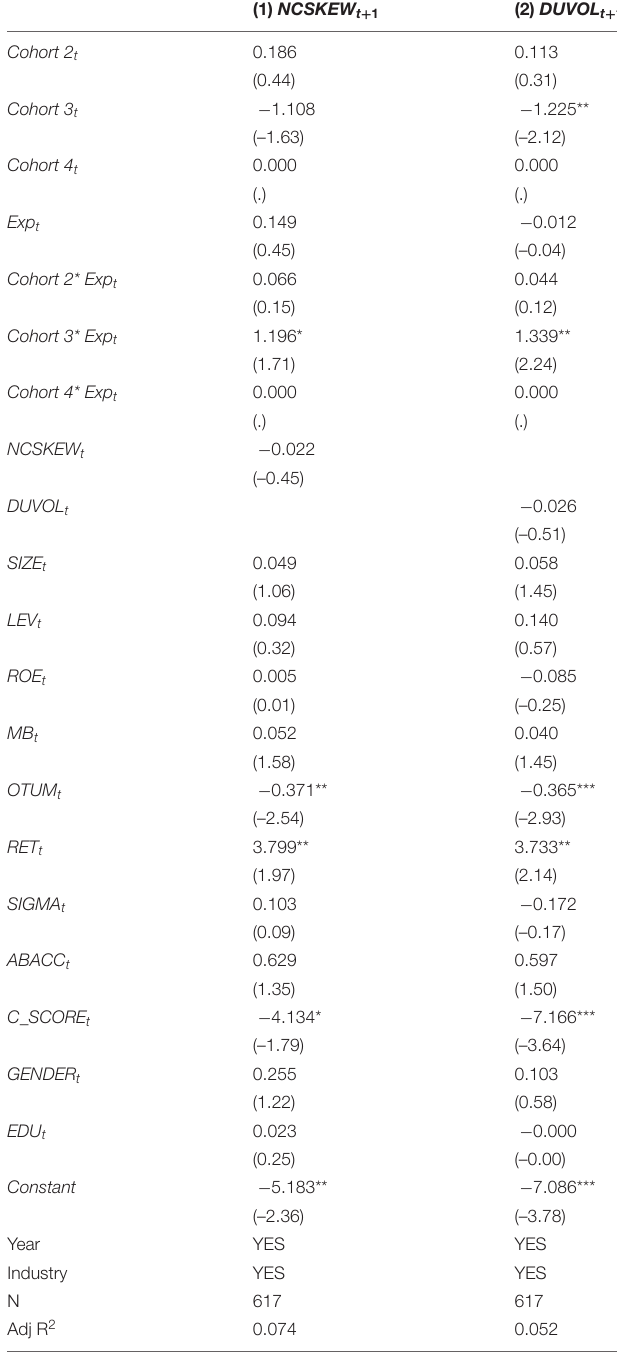
TABLE 10 | Robustness check: Controlling for potential bias due to local